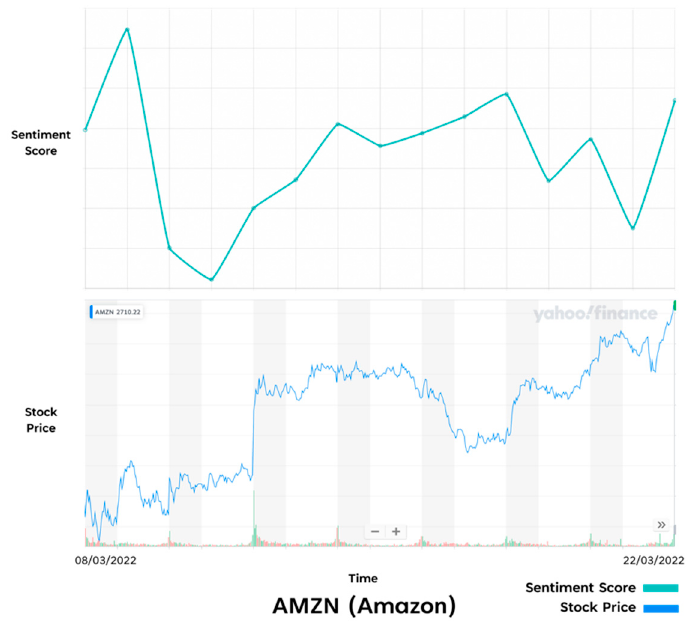
Figure 17. Comparison of Prototype results and Real-Life results—AMZN.